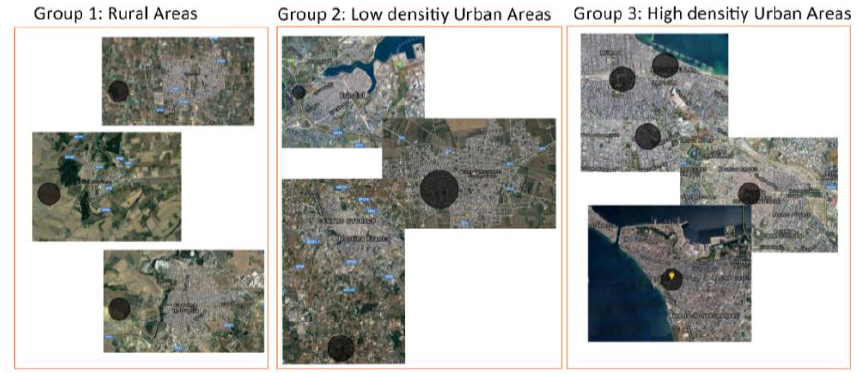
Fig. 6: Urbanization groups. Group 1: Rural Areas (Adelfia, Ascoli Satriano, Gravina in Puglia); Group2: Low density Urban Areas (Brindisi, San Pancrazio Salentino, Martina Franca); Group 3: High density Urban Areas (Bari, Foggia, Brindisi).